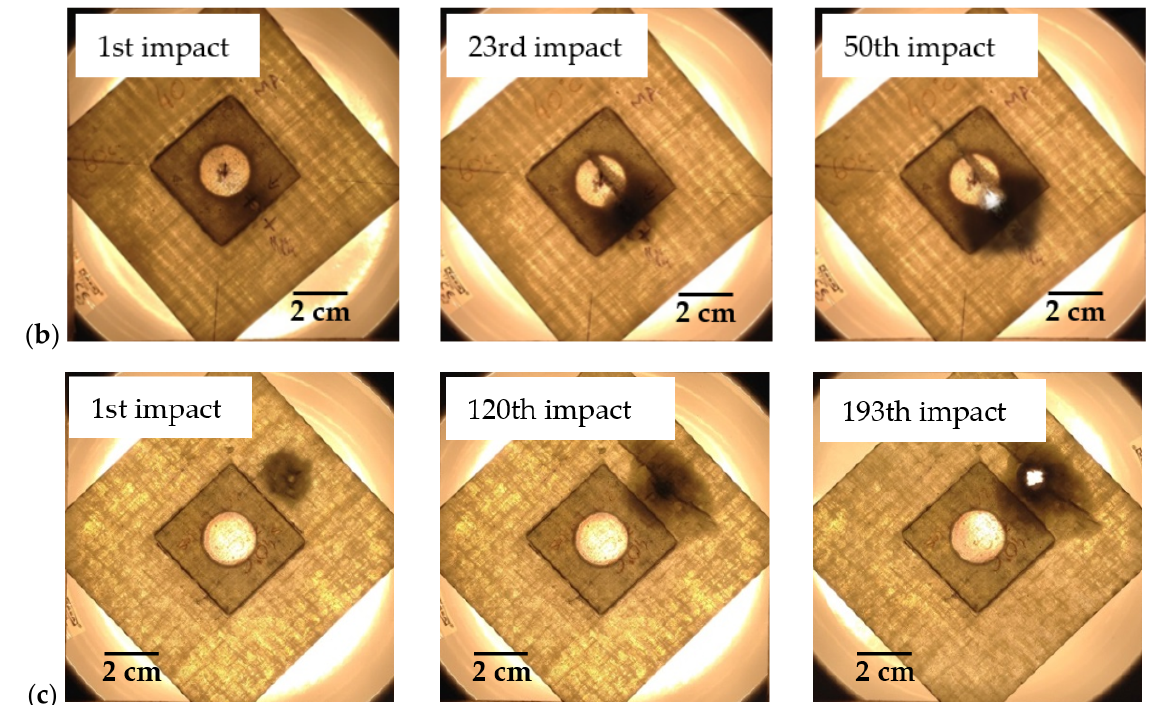
Figure 9. Damage evolution for repaired laminates: ( a ) Impacted at the centre; ( b ) Impacted at 15 mm from the centre; ( c ) Impacted at 35 mm from the centre.